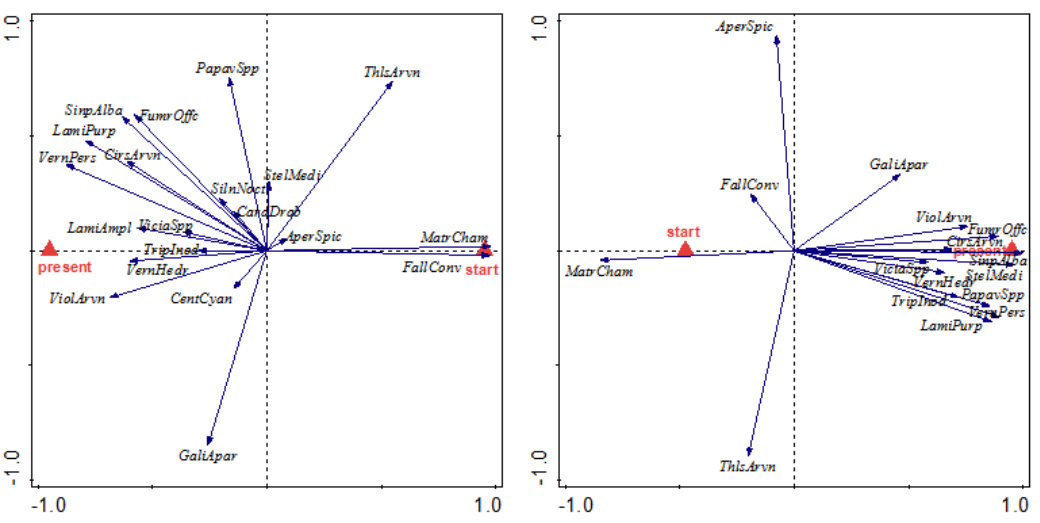
Figure 1. Temporal trends in weed species composition in winter wheat in Hněvčeves, comparison between trial beginning and the present (2016); Redundancy Analysis (RDA); simple crop rotation ( left ), multi-crop rotation ( right ).